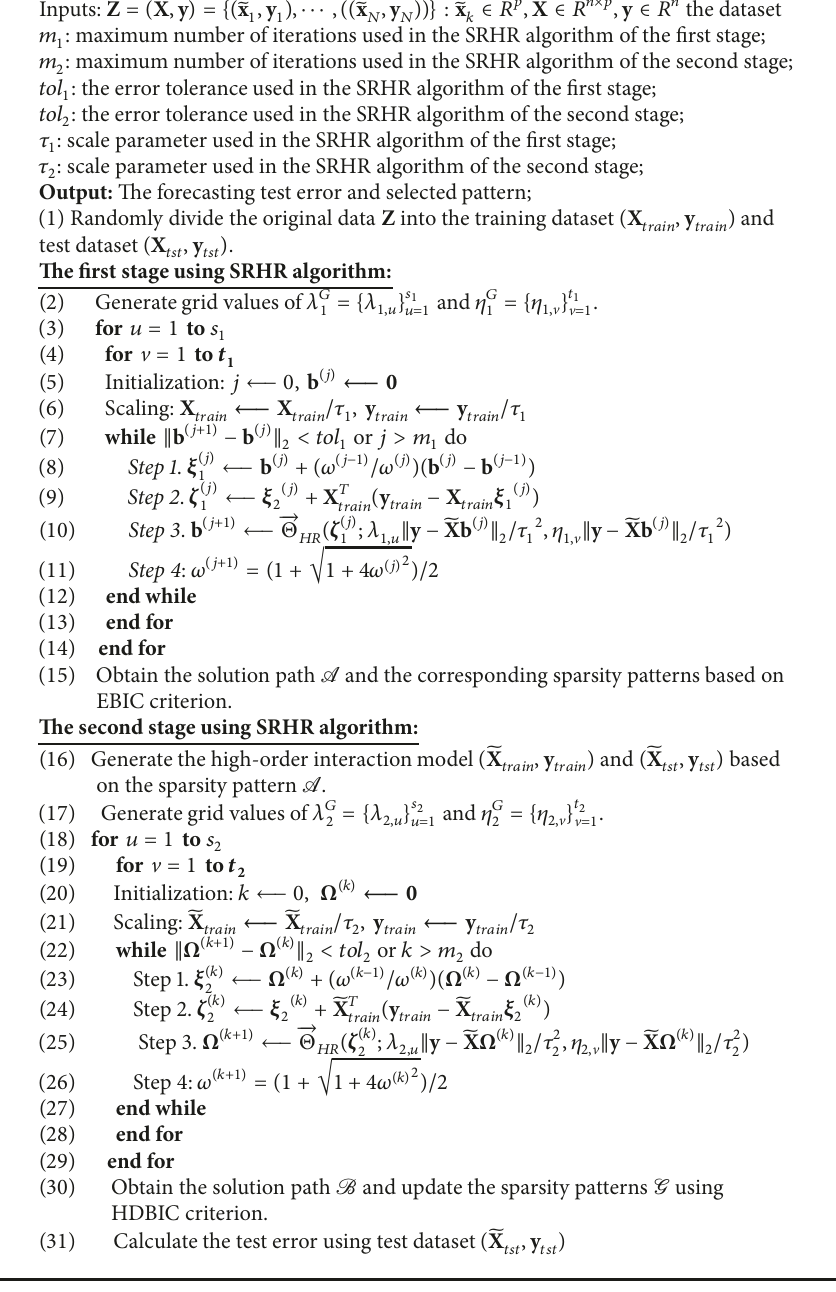
Algorithm 1: The TSRRHR